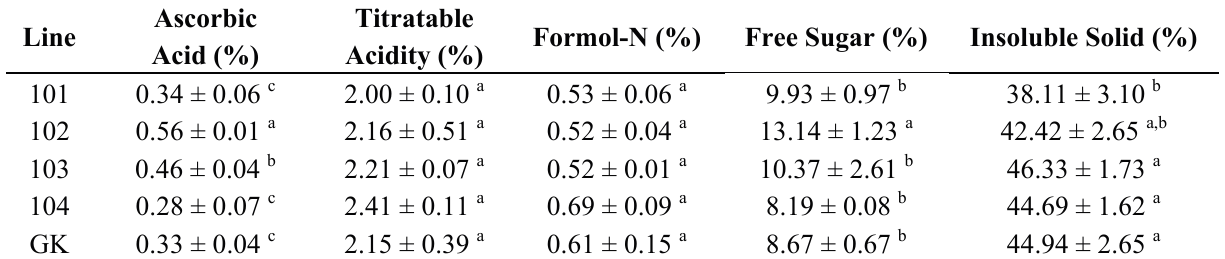
Table 2. Chemical constituents of broccoli florets.